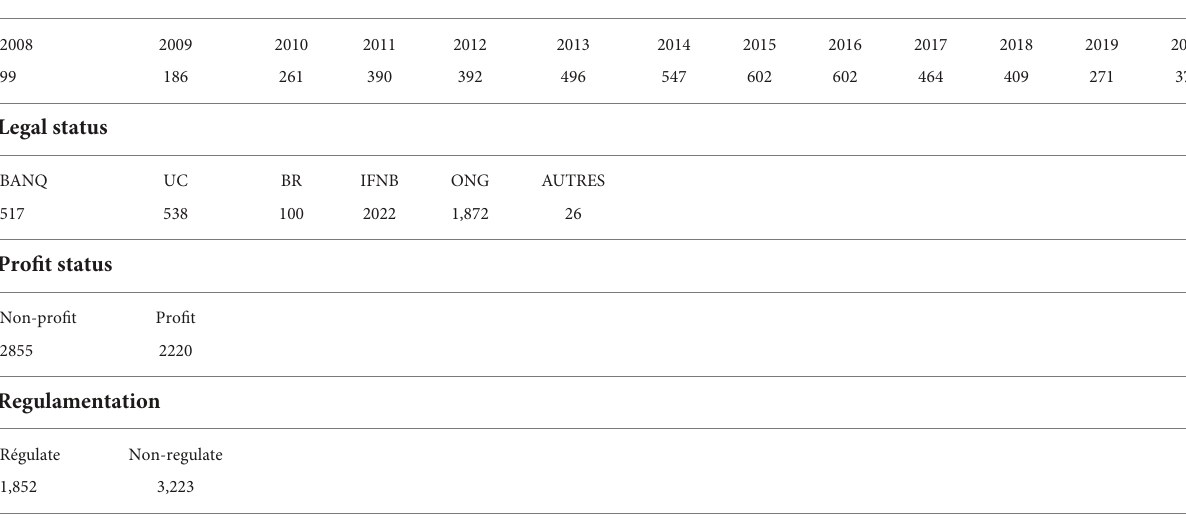
TABLE 4 Descriptive statistic of quantitative